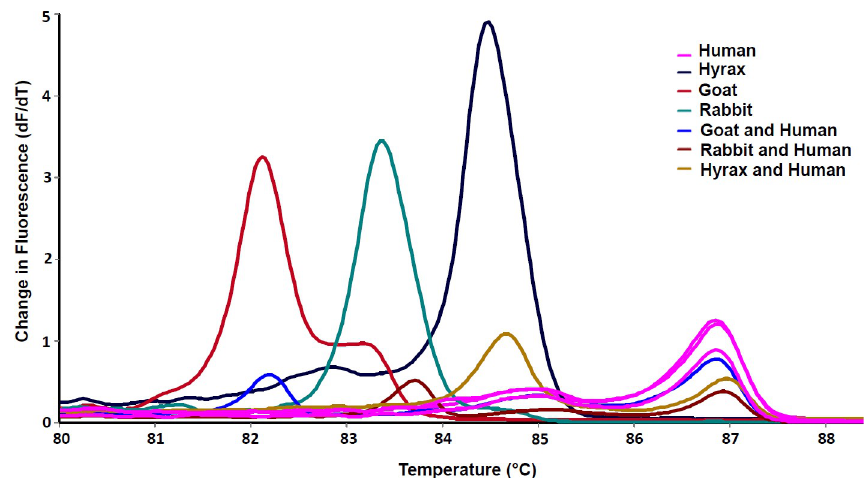
Fig 7. HRM profiles of vertebrate hosts present in sandfly bloodmeals using CYT-B . Positive controls are shown in the legend; human, rock hyrax, goat and rabbit. The melting profiles of mixed bloodmeals varied slightly compared to those of pure bloodmeals. Bloodmeal source detection failed in two partially blood-fed sandflies (2.70%). This could be due to the degradation of DNA in the bloodmeal. The e -values of BLAST search matches to GenBank sequences, percentage identities and GenBank accessions for some of the exclusive blood-fed sandflies are provided in Table 3.